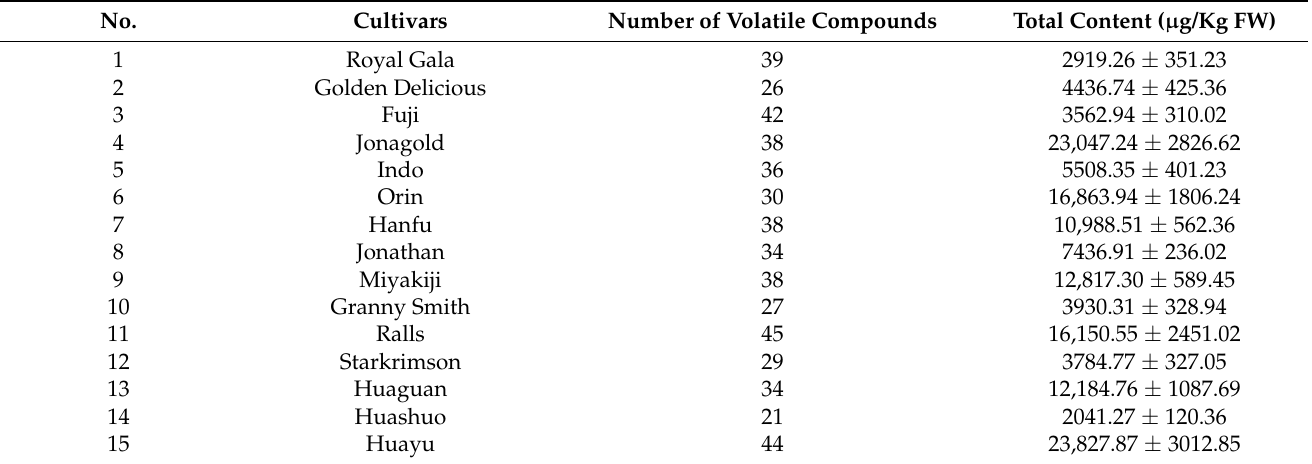
Table 3. Number of volatile compounds and total content of volatiles identified in the 40 apple cultivars.